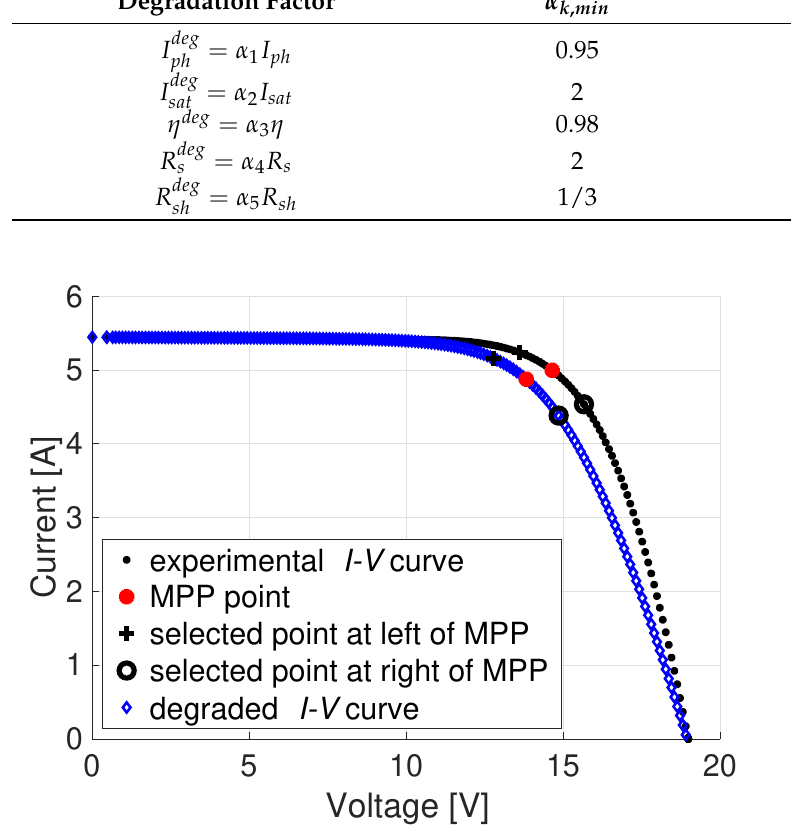
Figure 4. Healthy and degraded I - V curves with the selected points passed to the